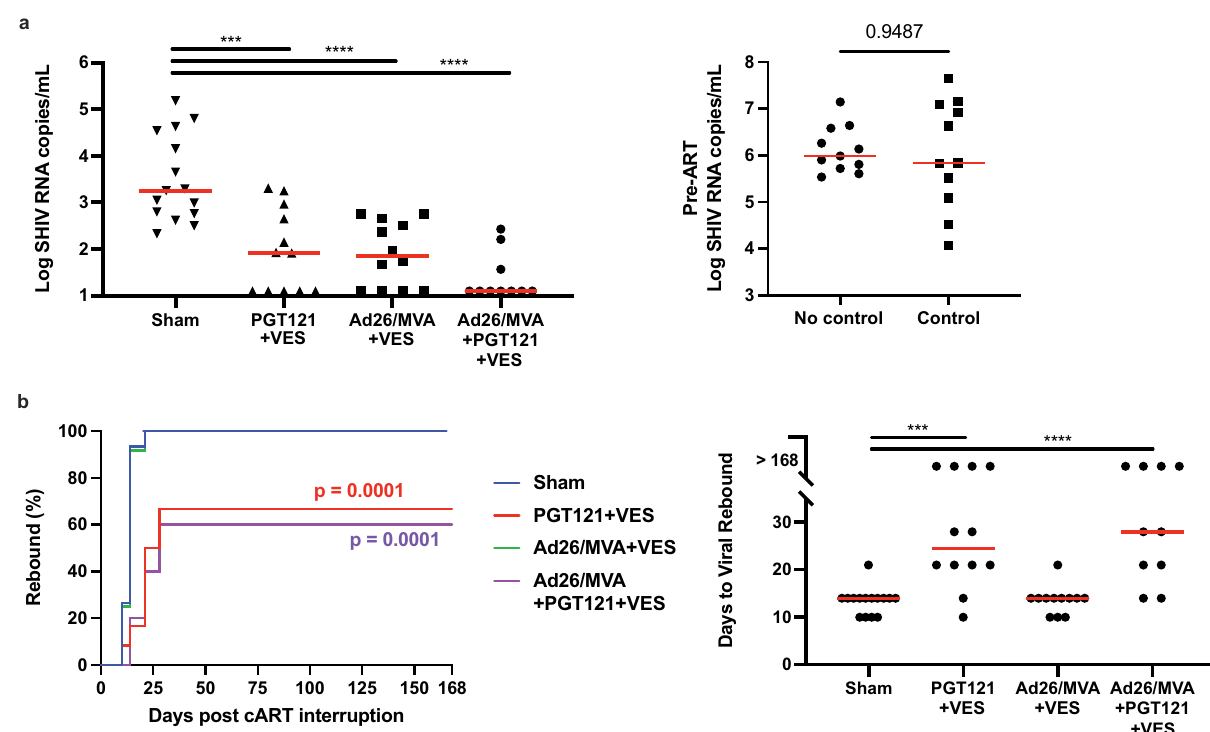
Fig. 4 All treatment interventions reduced post-treatment interruption viral loads. a Treatment interventions induced signi fi cantly lower setpoint viral loads as compared to sham (left). There was no association of virologic control with pre-ART peak viral loads in the Ad26/MVA vaccinated animals (right). Two-sided Mann – Whitney tests used to determine signi fi cance. b PGT121 treatment signi fi cantly delayed viral rebound. The Kaplan – Meier plot shows the signi fi cant difference between the PGT121 groups and sham group, determined via the Mantel-Cox log-rank test (PGT121, χ 2 = 14.37, p = 0.0001;